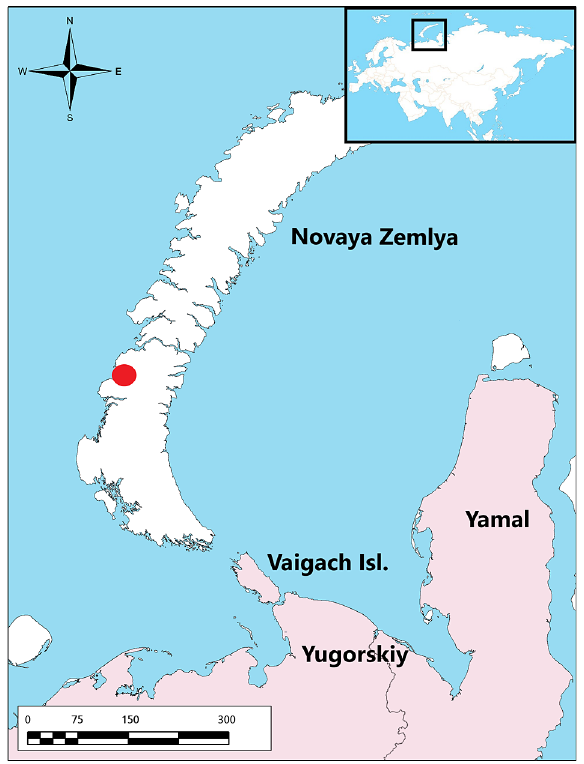
Figure 2. Distribution of Lepus timidus (Linnaeus, 1758) in the Novaya Zemlya region. The pink area indicates the previously known distribution of L. timidus , and the red dot indicates the novel record for the